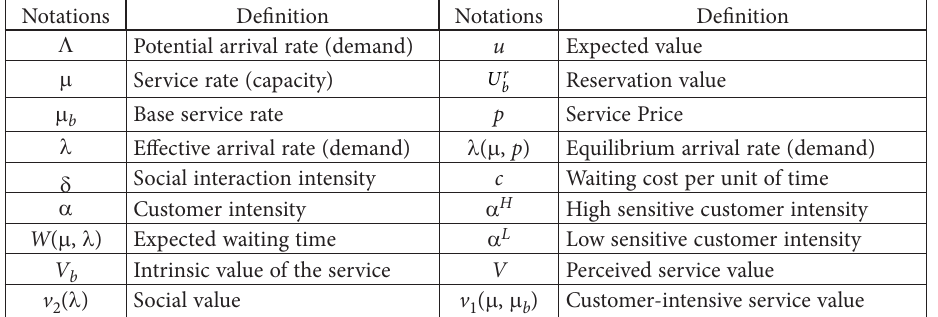
Table 1. Notations and